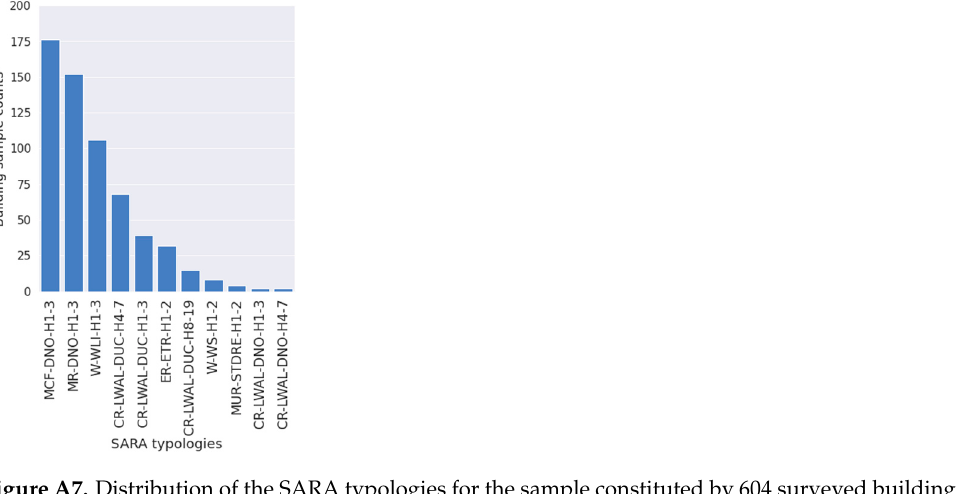
Figure A7. Distribution of the SARA typologies for the sample constituted by 604 surveyed buildings randomly distributed throughout Valparaíso (Figure A3).